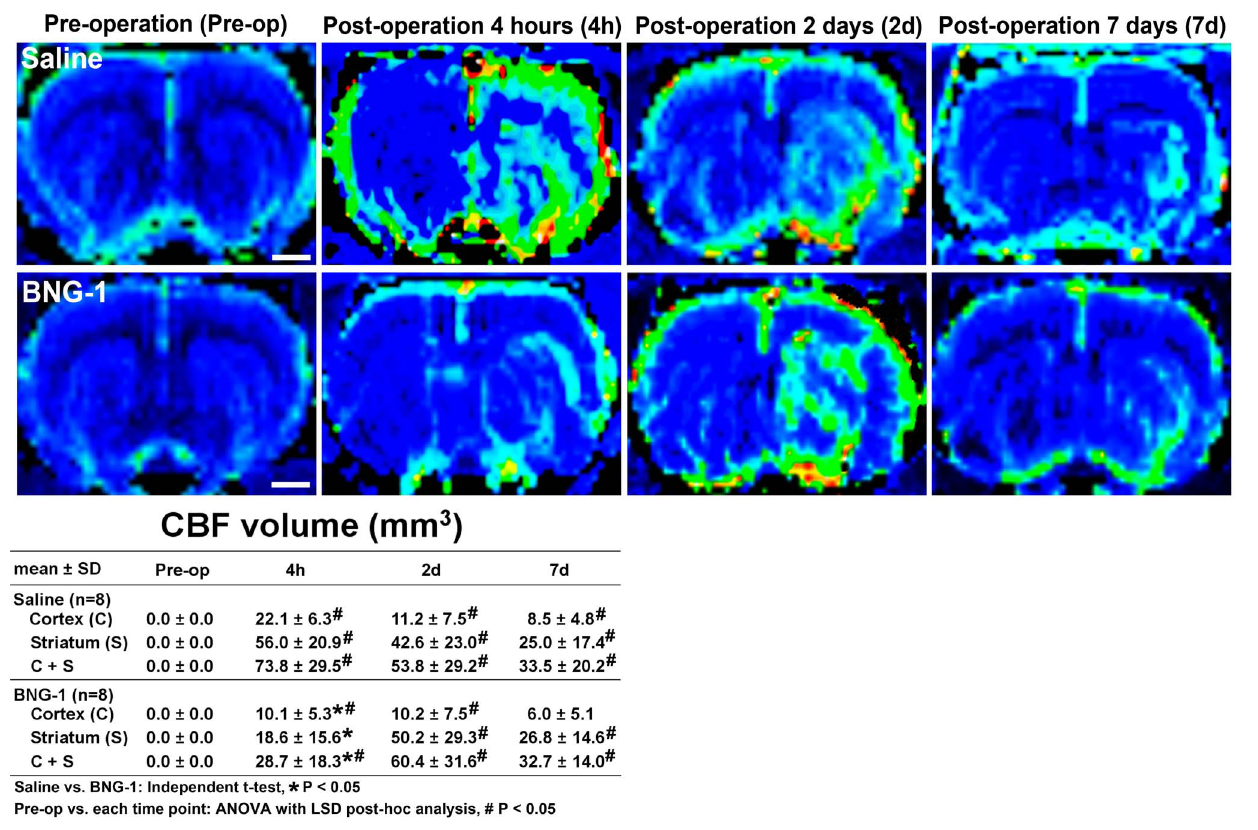
Fig. 3. Comparison of the temporal changes in the CBF after focal cerebral ischemia between the saline and BNG-1 treatments. CBF indicates that the postischemic hyperperfusion area (green area) is smaller in the BNG-1 group than the saline group at 4 h in both the lesion cortex and striatum, whereas no difference occurred after 2 d. The normal CBF region is blue. The bar in the pre-operation panels indicates 2.5